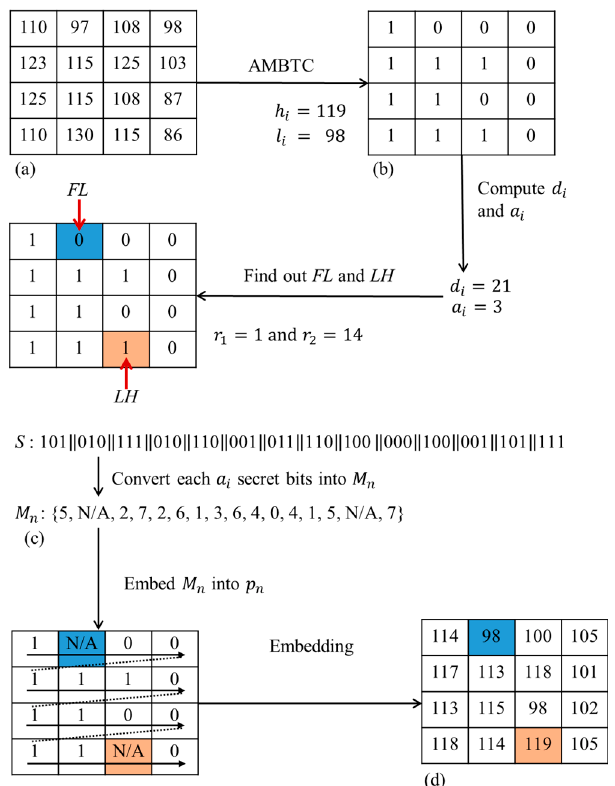
Figure 5. ( a ) Block b i sized 4 × 4, ( b ) The bit map of block b i , ( c ) Secret data S and ( d ) The modified block b (cid:48) sized 4 × 4.